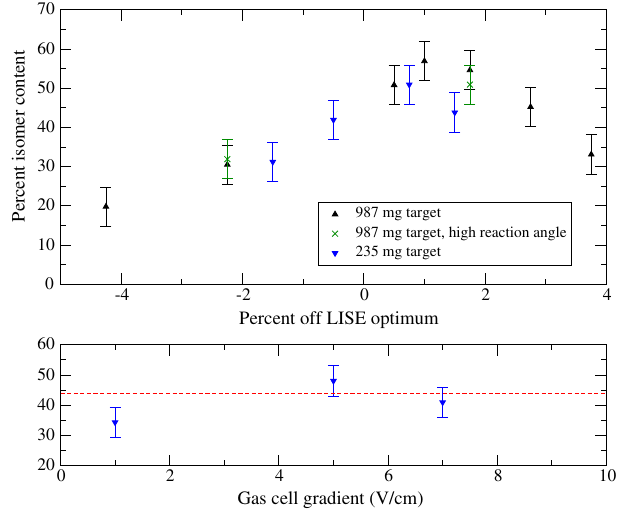
FIG. 3. Isomer content as a percent of the total 38 K rate for some of the different parameters varied. Top panel: Isomer content in percent as a function of the percent change, positive or negative, off the LISE ++ [19] predicted optimum B ρ 1 ; 2 for 38 K production with the A1900, for two different fragmentation target thick- nesses (thicker target, black; thinner target, blue). The gap around − 1% for the thicker ( 987 mg = cm 2 ) beryllium target is the location of the primary CCF beam. The momentum acceptance of the A1900 for this measurement is 0.5% ( (cid:2) 0 . 25% ), so these data represent the center of the momentum “ bite ” at each step. In addition, two measurements were taken at a high angle between the fragmentation target and the A1900 for the thicker target, shown as a green ×. The high angle did not alter the results, within uncertainty. Bottom panel: Isomer content in percent as a function of the gradient, in V/cm, in the Argonne Gas Stopper. The red dashed line shows the isomer fraction when using the “ nominal ” gas cell gradient settings, which is a nonconstant and noncontinuous field. The three points, all taken with the thinner fragmentation target, represent constant gradient